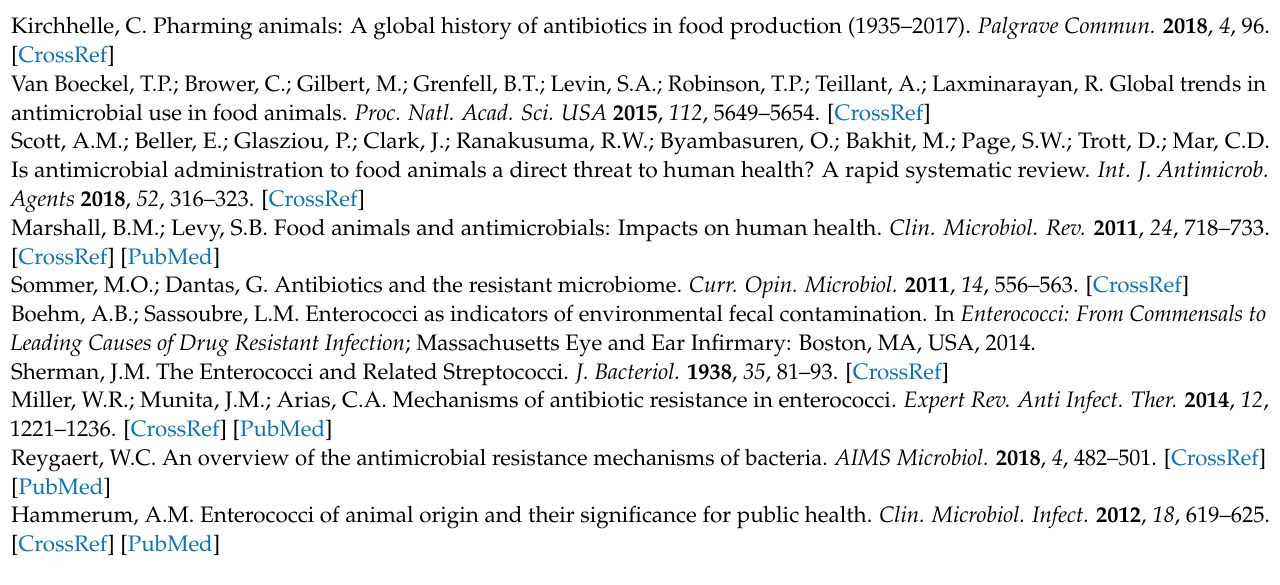
Table S3: the antimicrobial resistance phenotype and genotype of 62 E. faecium isolates obtained at entry and exit from feedlot cattle faecal samples and subjected to whole genome sequencing